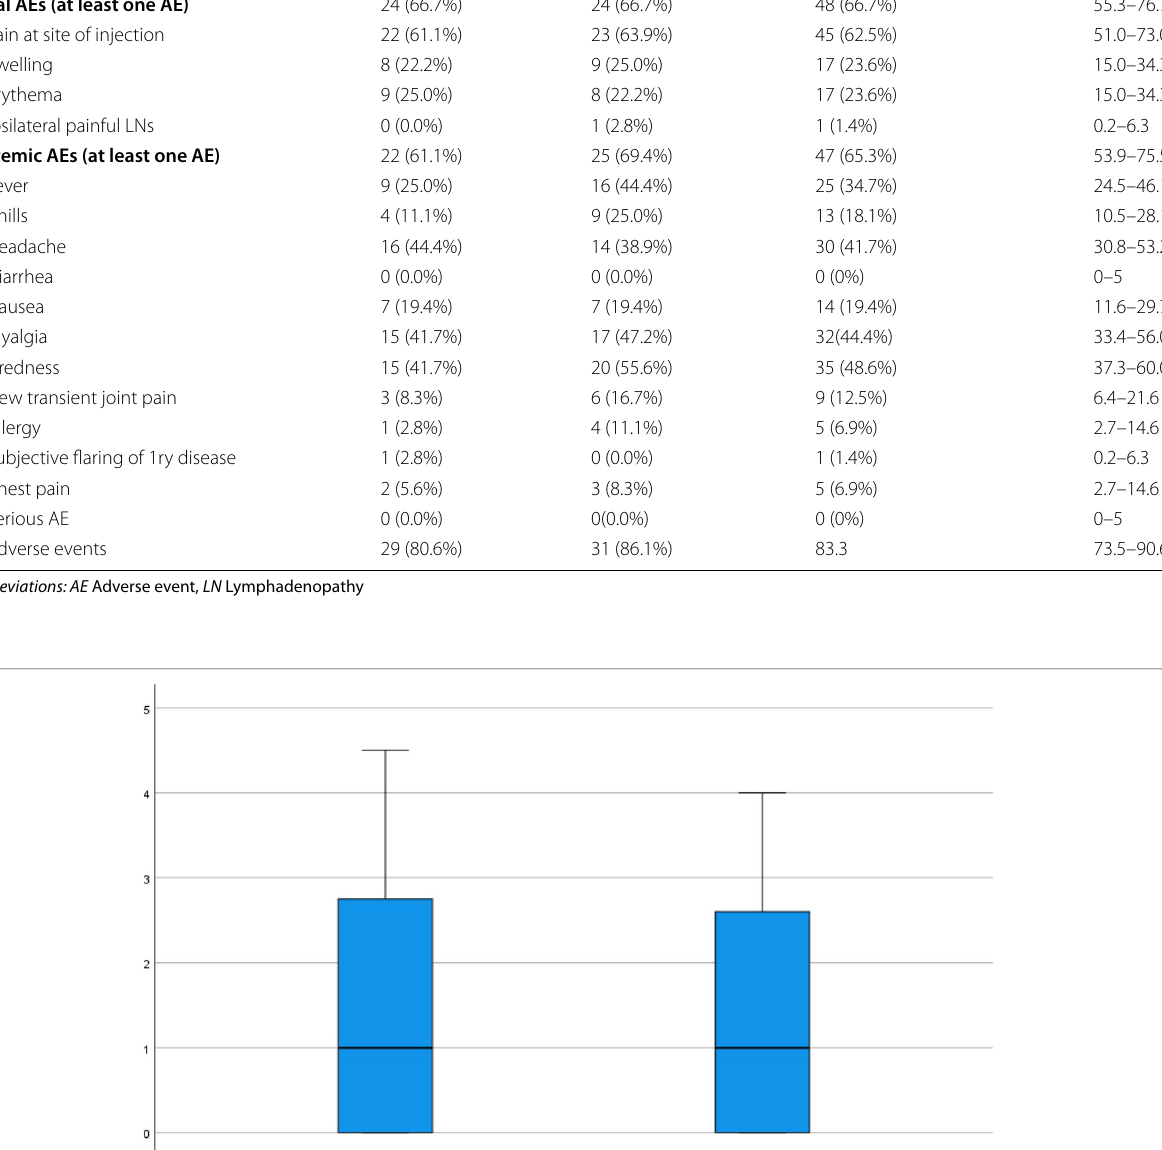
Table 2 Post-vaccination adverse events (AE) Post-vaccination adverse events (AEs)